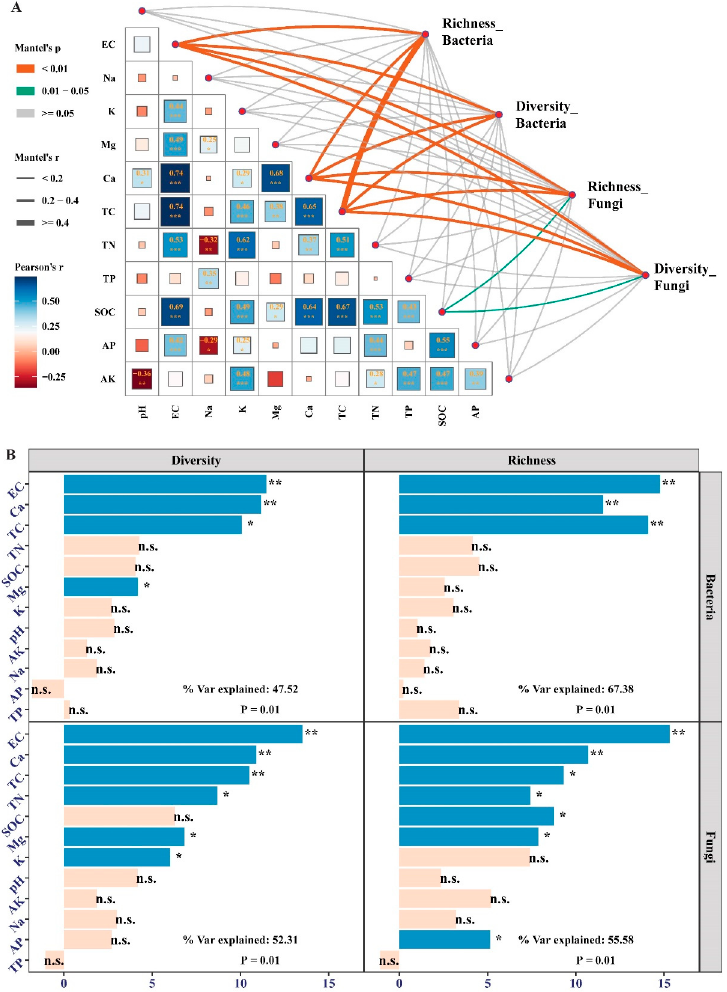
Figure 6. Pearson correlation and Mantel test between ( A ) the richness and diversity of bacterial and fungal communities and soil physicochemical properties and ( B ) the Random Forest calculated contribution of soil physicochemical properties to the richness and diversity of bacterial and fungal communities at different stages of afforestation by aerial sowing in the northeastern Tengger Desert, China. Significance level, * p < 0.05, ** p < 0.01, *** p < 0.001, and n.s., not signi fi cant.